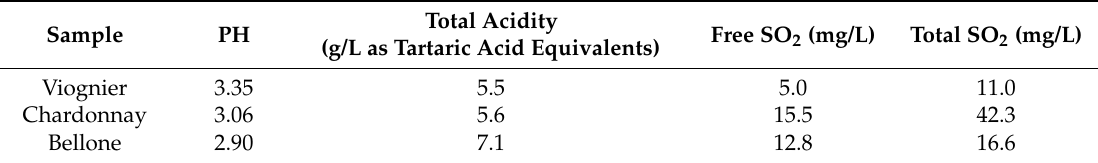
Table 3. General analysis of three white